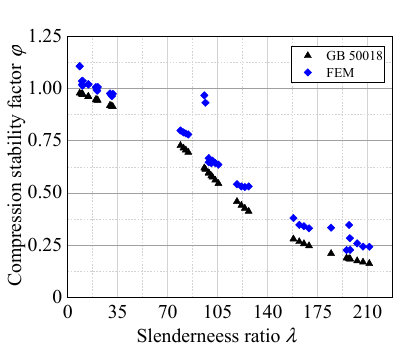
Figure 22. Stability factor of standard and numerical analyses.